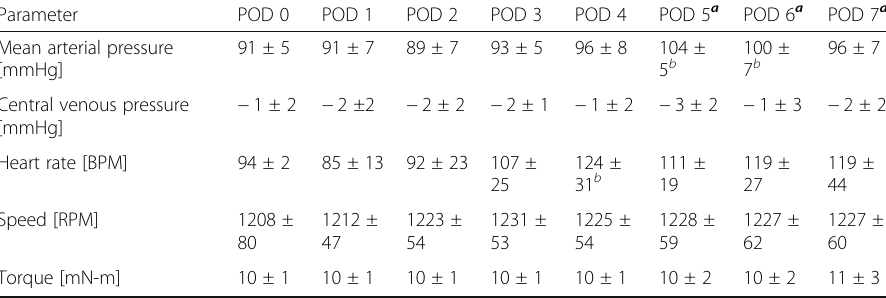
Table 1 Hemodynamic and device parameters